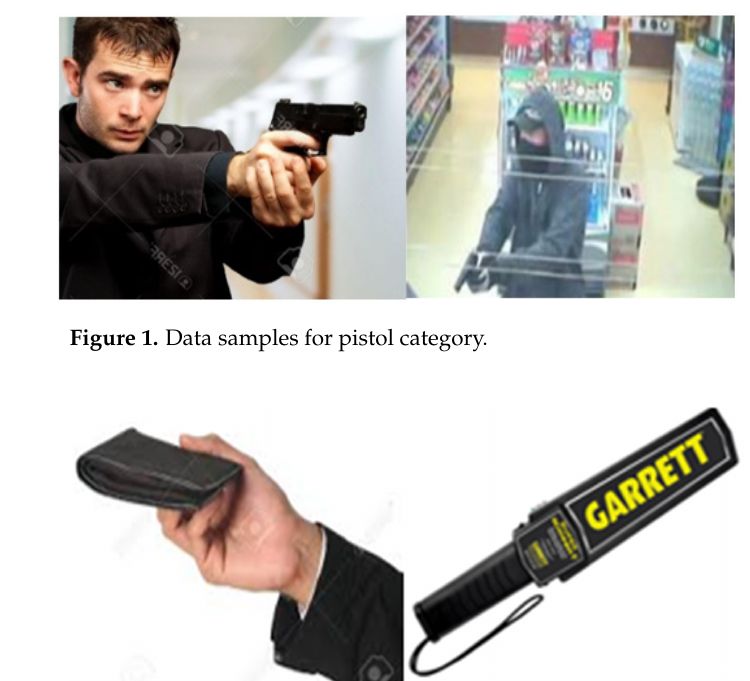
Figure 2. Data samples for non-pistol category.